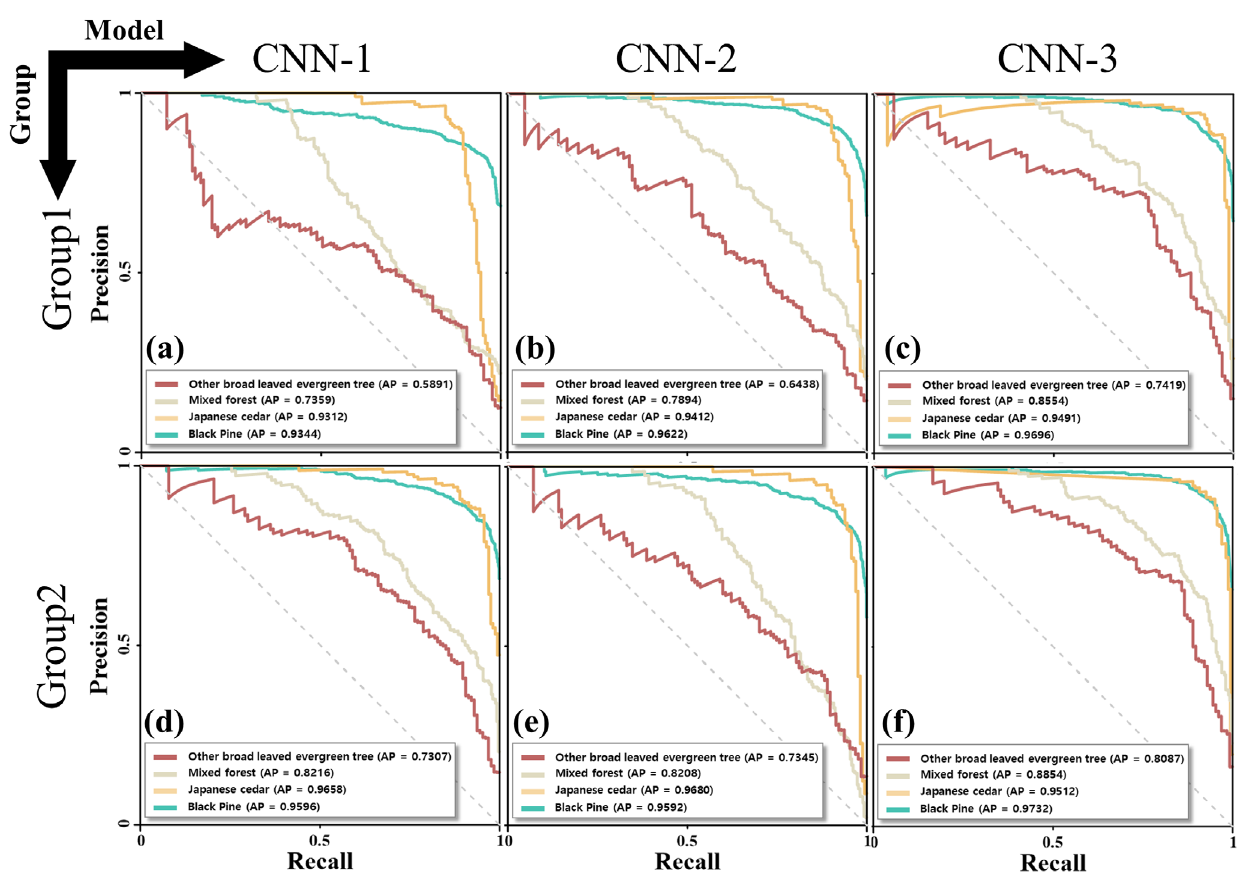
Figure 8. Precision-recall curves: ( a – c ) CNN-1, CNN-2, and CNN-3 models in Group 1, respectively; ( d – f ) CNN-1, CNN-2, and CNN-3 models in Group 2, respectively.